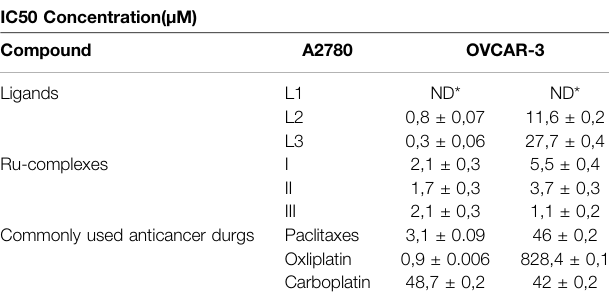
TABLE 4 | IC 50 values of newly synthesized TSC ligands and Ru complexes at micromolar (µM) concentration (ND *:Non Detectable). IC50